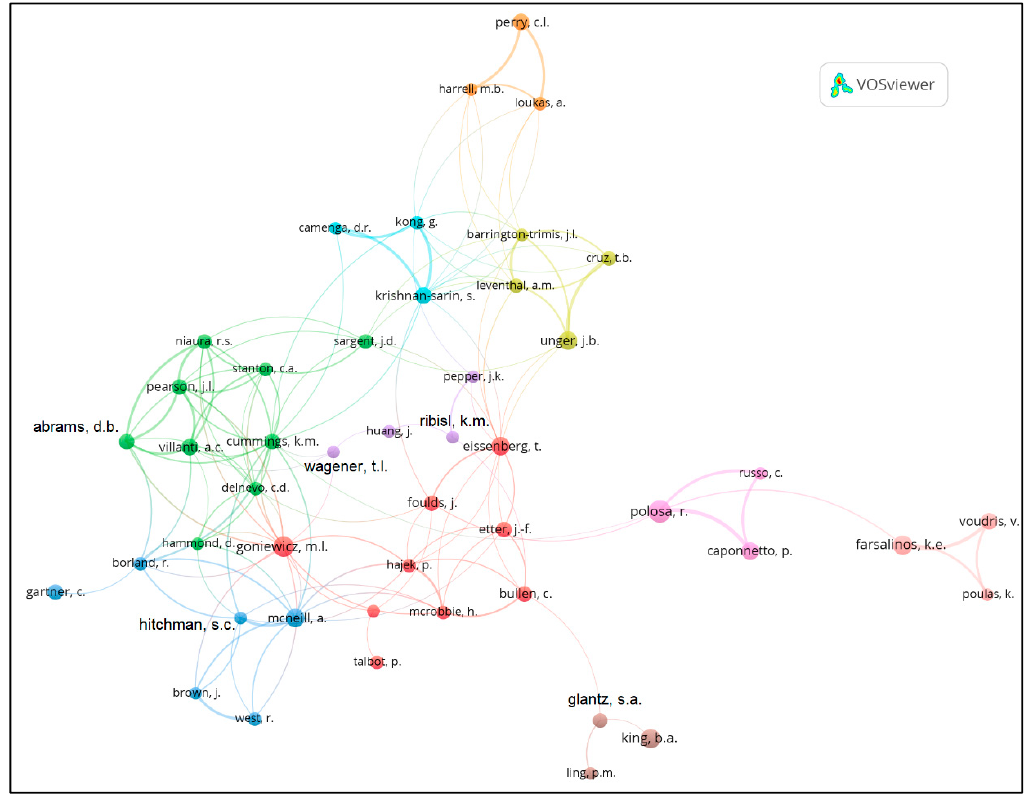
Figure 3. Network map of top authors in electronic cigarettes from 2003 to 2018. Authors were required to have at least 20 publications for inclusion. Colors indicate typical co-authors.